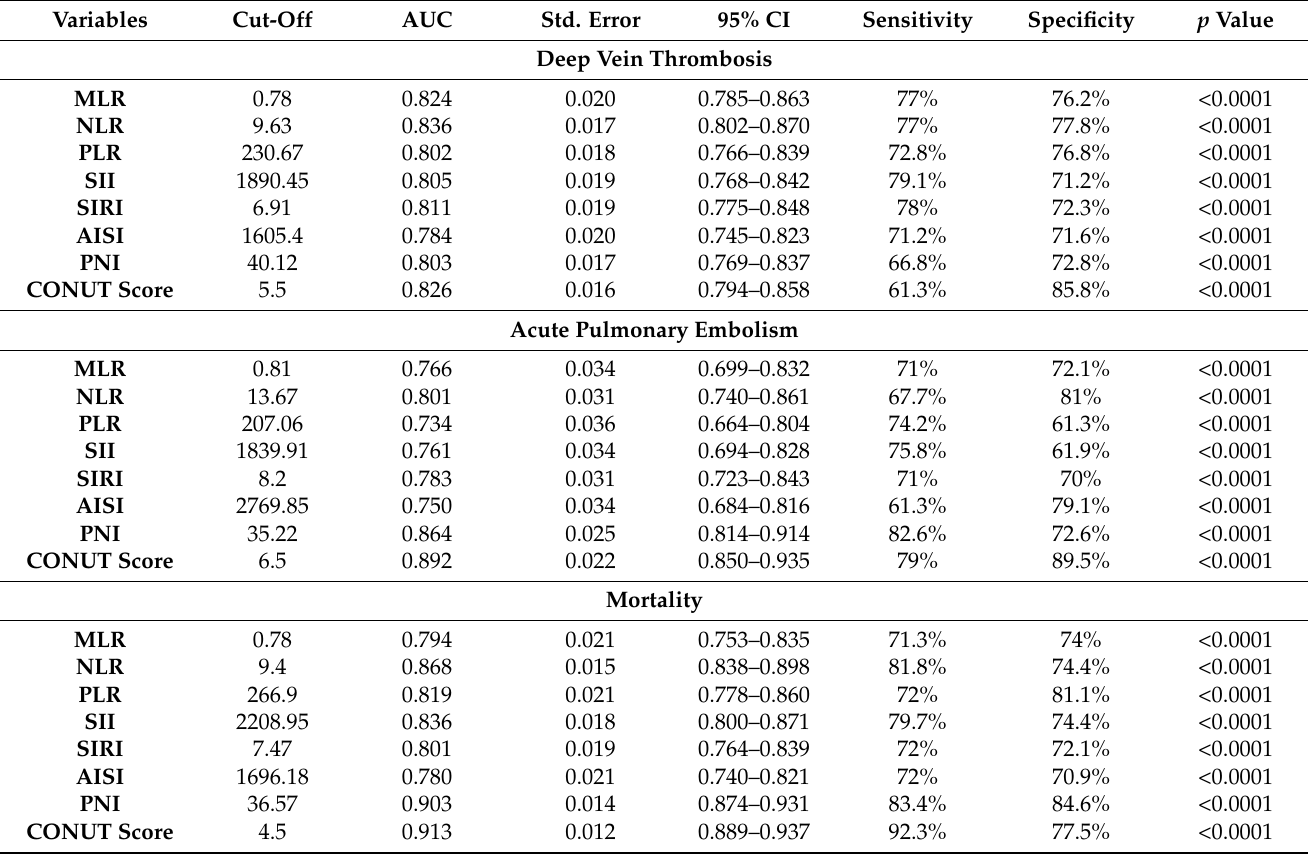
Table 3. The AUC of the ROC curve, 95% confidence interval, sensitivity, and specificity of the inflammatory and nutritional markers.